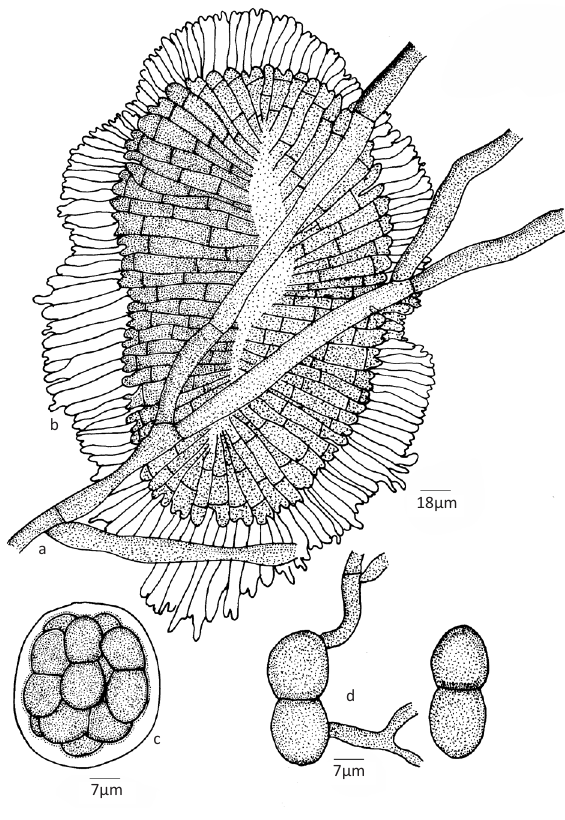
a - Mycelium; b - Thyriothecium; c - Ascus; d -